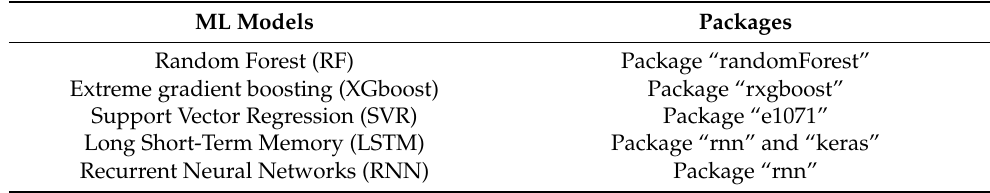
Table 2. R program packages used for the prediction of methane